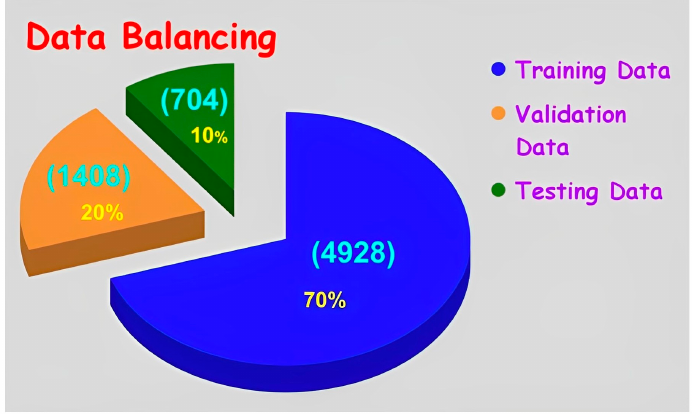
Figure 10. Imagery data balancing of particular sewer blockage type.